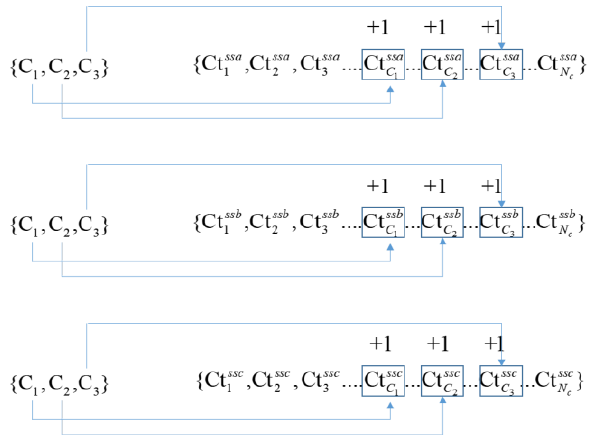
Figure 6. Vote process in the initial match step.